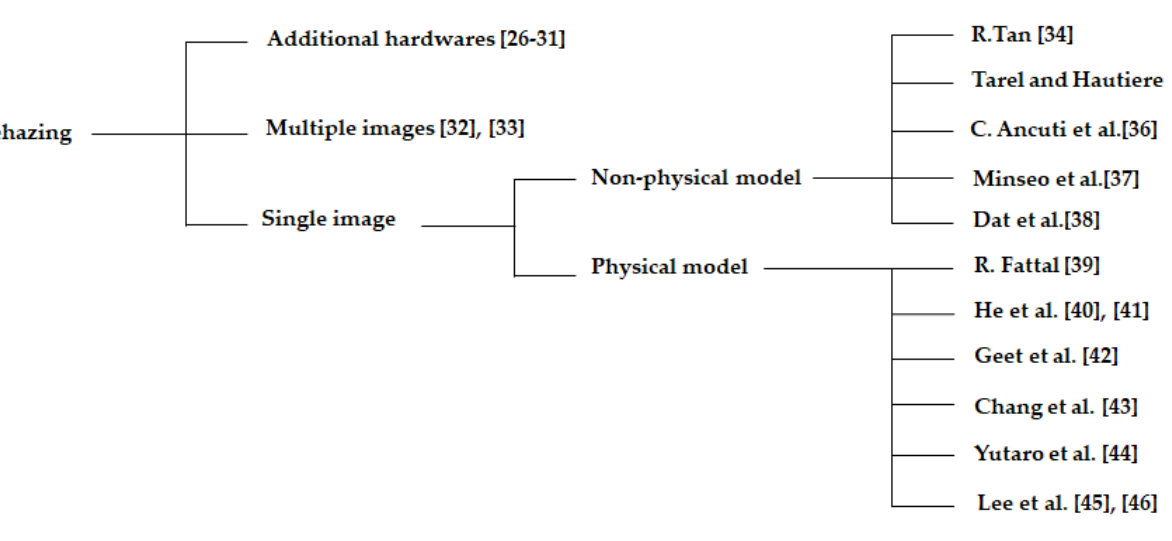
Figure 1. Classification table for image dehazing